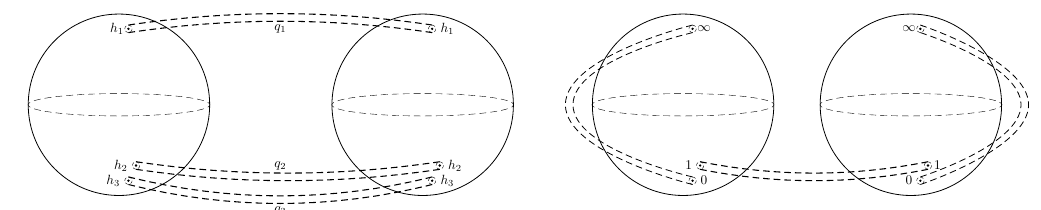
Figure 8. The plumbing construction for a genus two Riemann surface in two